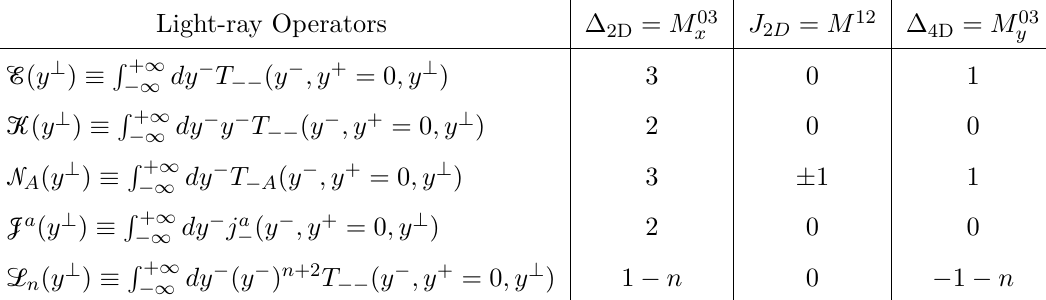
Table 2 . Summary of the light-ray operators we’ve encountered, as well as their scaling dimensions for the various symmetry transformations we encounter in the x and y coordinate systems and how these translate to their celestial